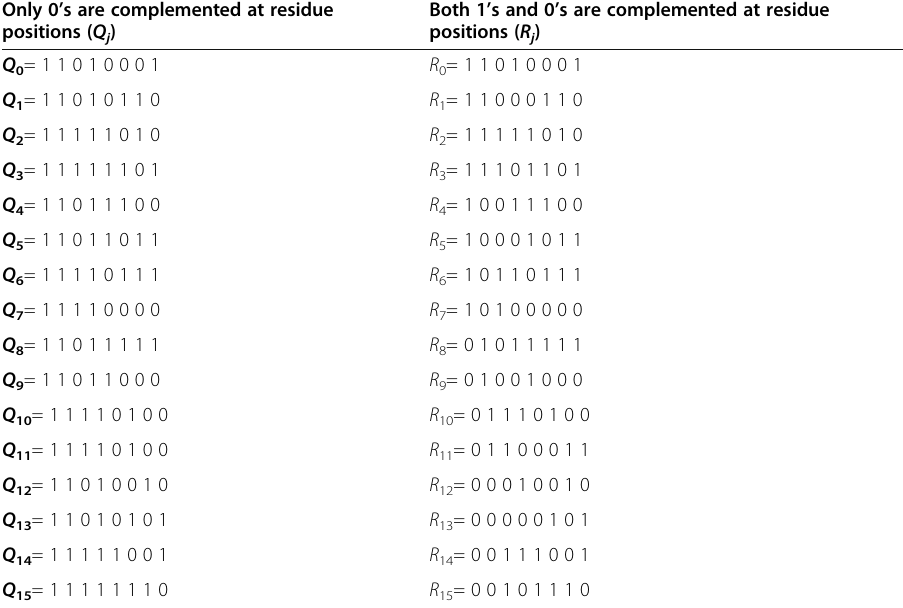
Table 5 Generation of codes ( Q j and R j ) as per step 2, cases 2 and 3 Only 0 ’ s are complemented at residue positions ( Q j )